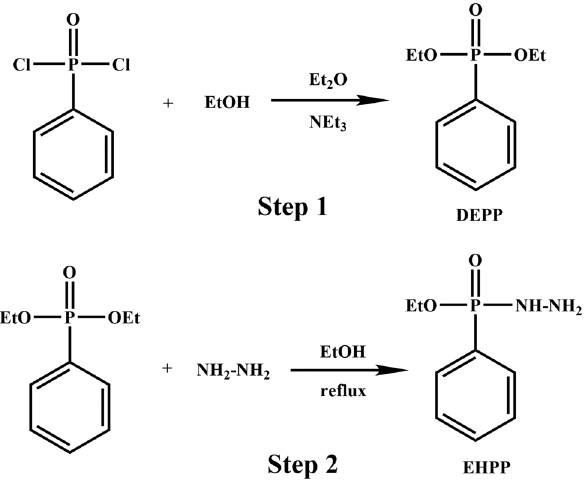
Figure 1: Synthetic process of